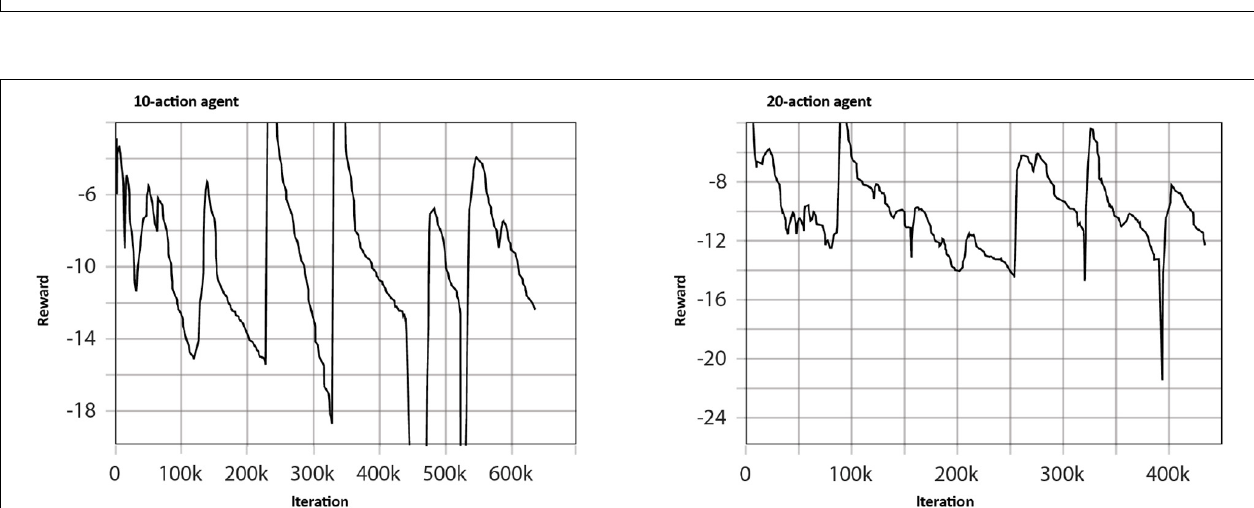
FIGURE 6 | Trend of the reward achieved by the 10-action and 20-action agents over consecutive training iterations.